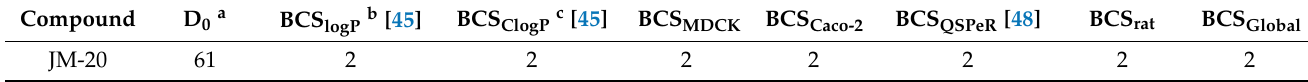
Table 5. A provisional BCS classification for JM-20, based on different in situ , in vitro and in silico permeability models.